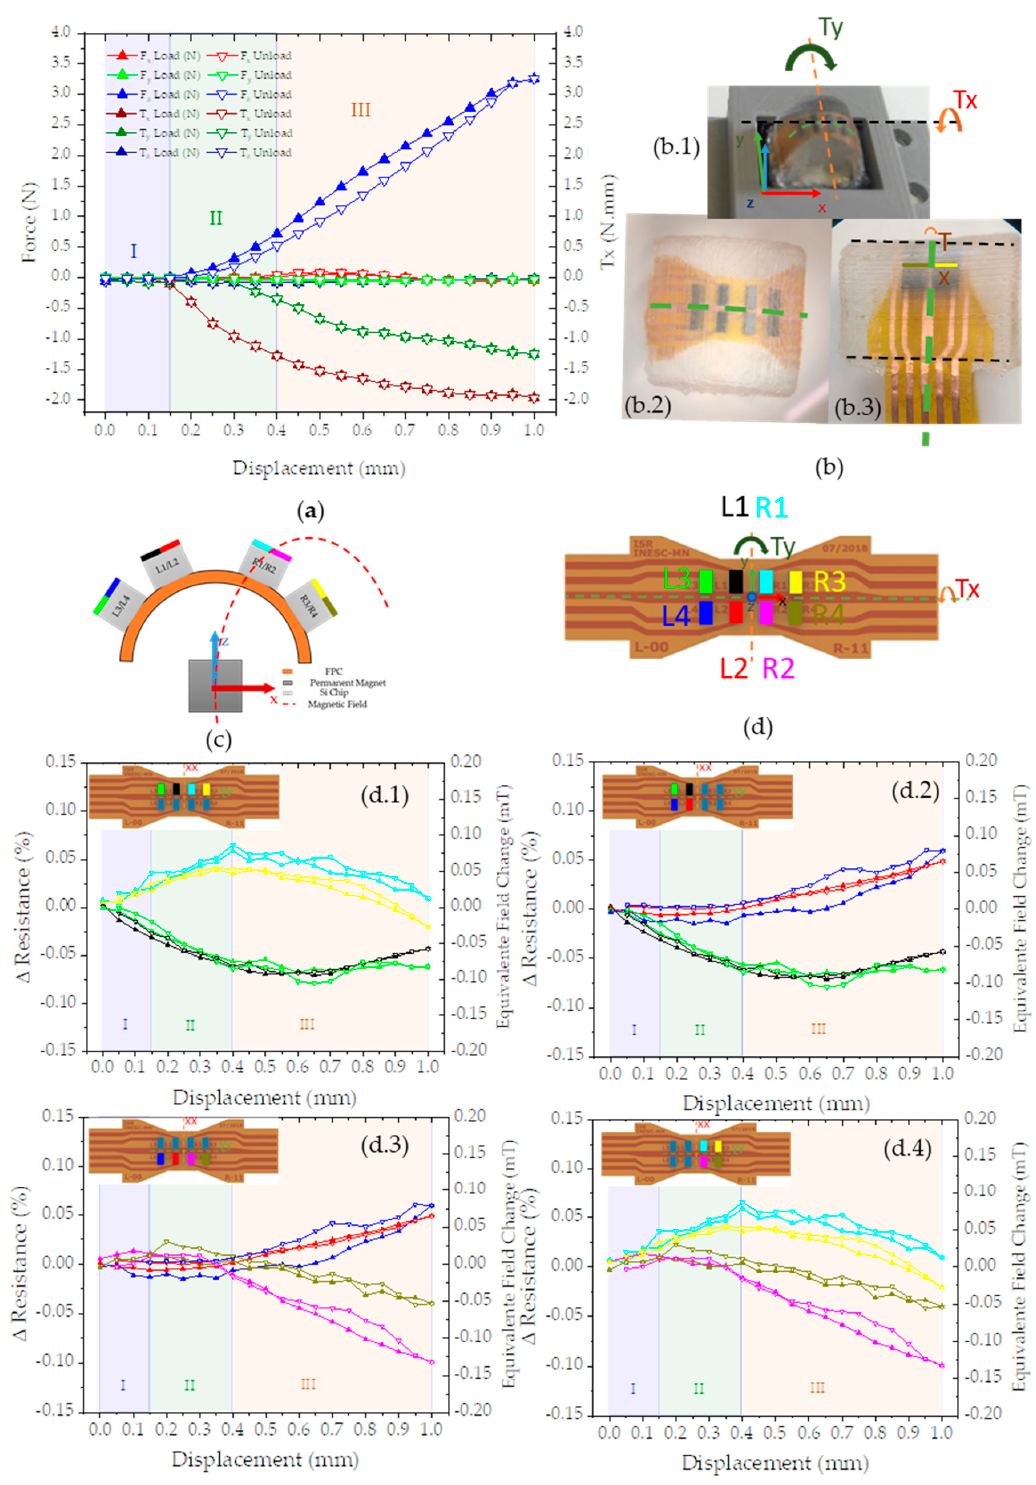
Figure 13. ( a ) Force and momentum data from ATI nano 17 ( F x , F y , F z , T x , T y and T z ) for the loading and unloading phases. ( b ) Detail of the sensor with the T x and T y schematics detailed. ( c ) A schematic view of the sensor matrix in the XZ plane; ( d ) a schematic view of the sensor matrix in the XY plane, showing the sensors; ( d.1 ) set of four graphs showing the symmetry for the sensor output by choosing sensors: ( d.2 ) with positive y coordinates (odd numbers—L1, R1, L3, R3); ( d.2 ) with negative x coordinates (left side—L1, L2, L3, L4) ( d.3 ) with negative y coordinates (even numbers—L2, R2, L4, R4); ( d.4 ) with positive x coordinates (right side—R1, R2, R3,